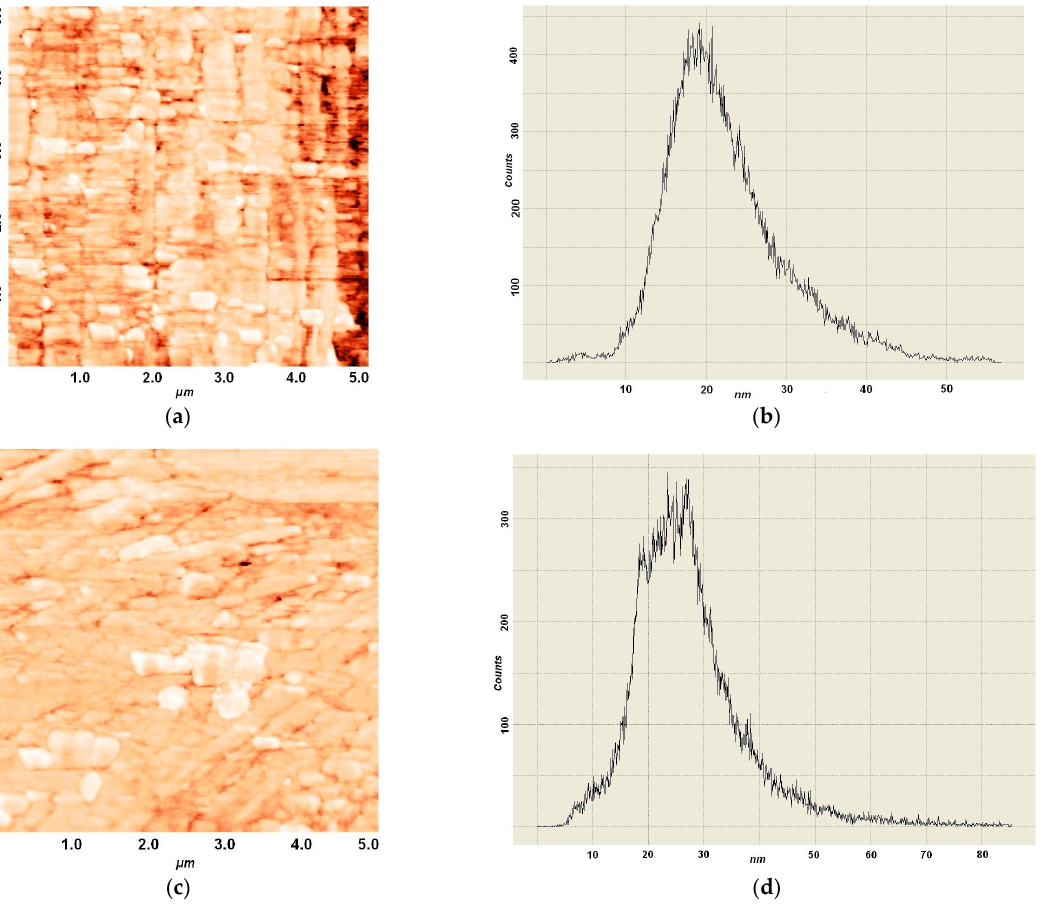
Figure 5. Images of a 5 × 5 µm polyester film surface with a coating formed from TFE/AC telomers (phase representation)—( a , c )—and histograms of the peak heights of these surface areas—( b , d ): ( a , b ) are the initial coating; ( c , d ) are the coating after abrasion. The study method is atomic-force microscopy.